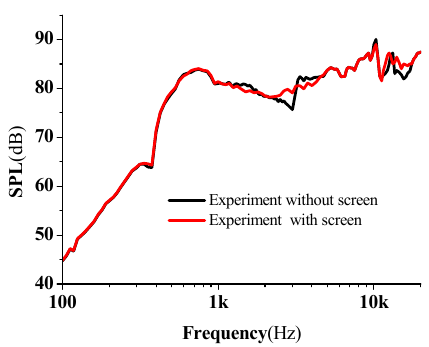
Figure 17. Experiment results (with/without screen).